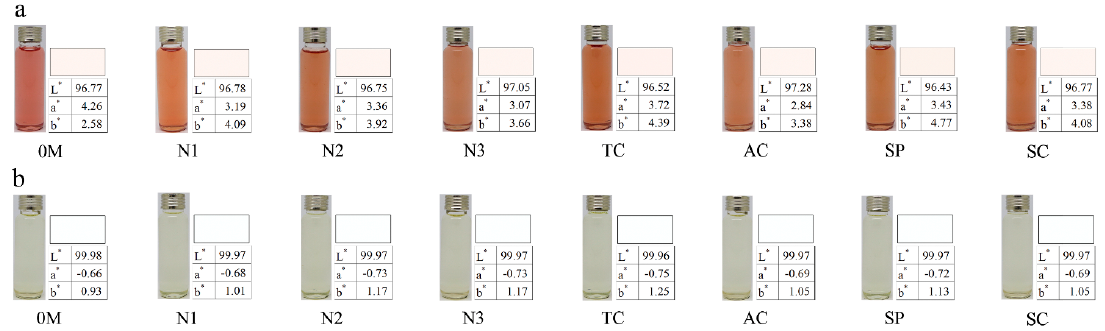
Figure 6. Sample photos and chromatic parameters of rosé ( a ) and white wines ( b ) prior to and after an 18-month bottle aging.